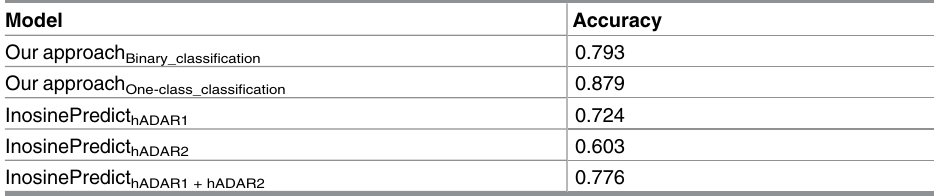
Table 4. Comparison of